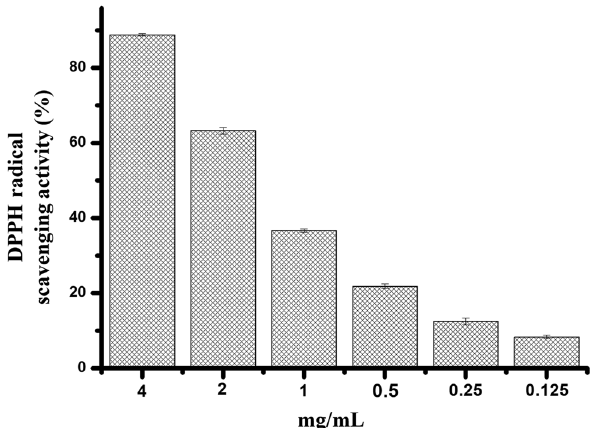
Figure 1: DPPH scavenging activity ( % ) of di ff erent concentrations ( 4 – 0.125 mg/mL ) of the crude MFC extract.